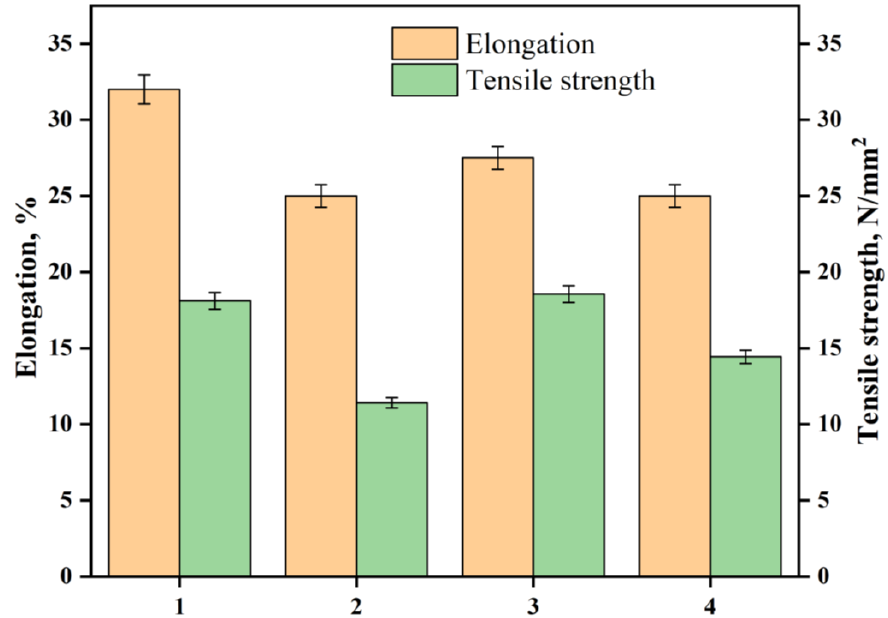
Figure 6. Effect of elongation and tensile strength on (1) PET, ( 2) PET hydrazide, (3) PET hydrazide- AgNP-PDA, and (4) PET hydrazide-AgNP.